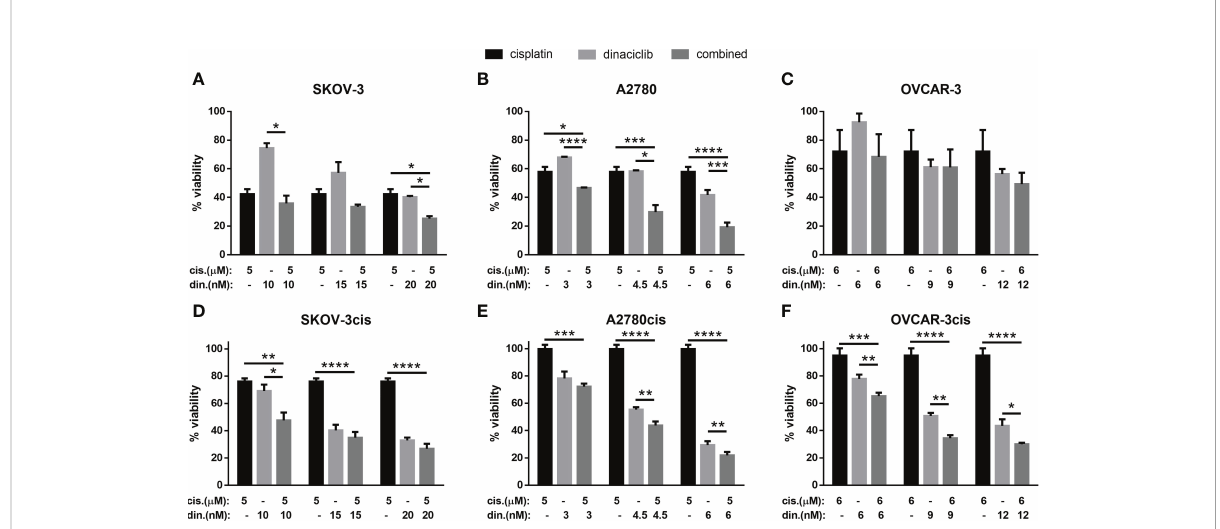
FIGURE 3 Dinaciclib combines additively with cisplatin in OC cell lines regardless of cisplatin sensitivity. Cells were treated either individually, or in combination with dinaciclib and cisplatin at concentrations re fl ective of the sensitivities of each cell line to these drugs. Viability was measured after 72 h and normalised to media controls for (A) SKOV-3, (B) SKOV-3cis, (C) A2780, (D) A2780cis, (E) OVCAR-3 and (F) OVCAR-3cis cells. Data are expressed as mean of three independent experiments with error bars representing standard deviation. Statistical signi fi cance was calculated by ANOVA followed by Dunnett ’ s test. *p value < 0.05, **p value < 0.01, ***p value < 0.001, ****p value <